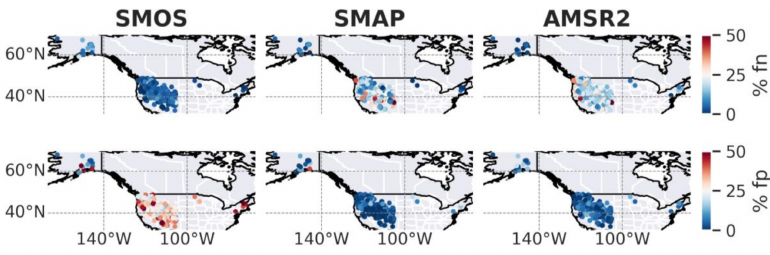
Figure 11. The percentages of false positives (fp) and false negatives (fn) averaged over time (2016–2019) of all SNOTEL and SCAN stations per SFI flag dataset for threshold t1 (SWE > 50 mm and / or TS <